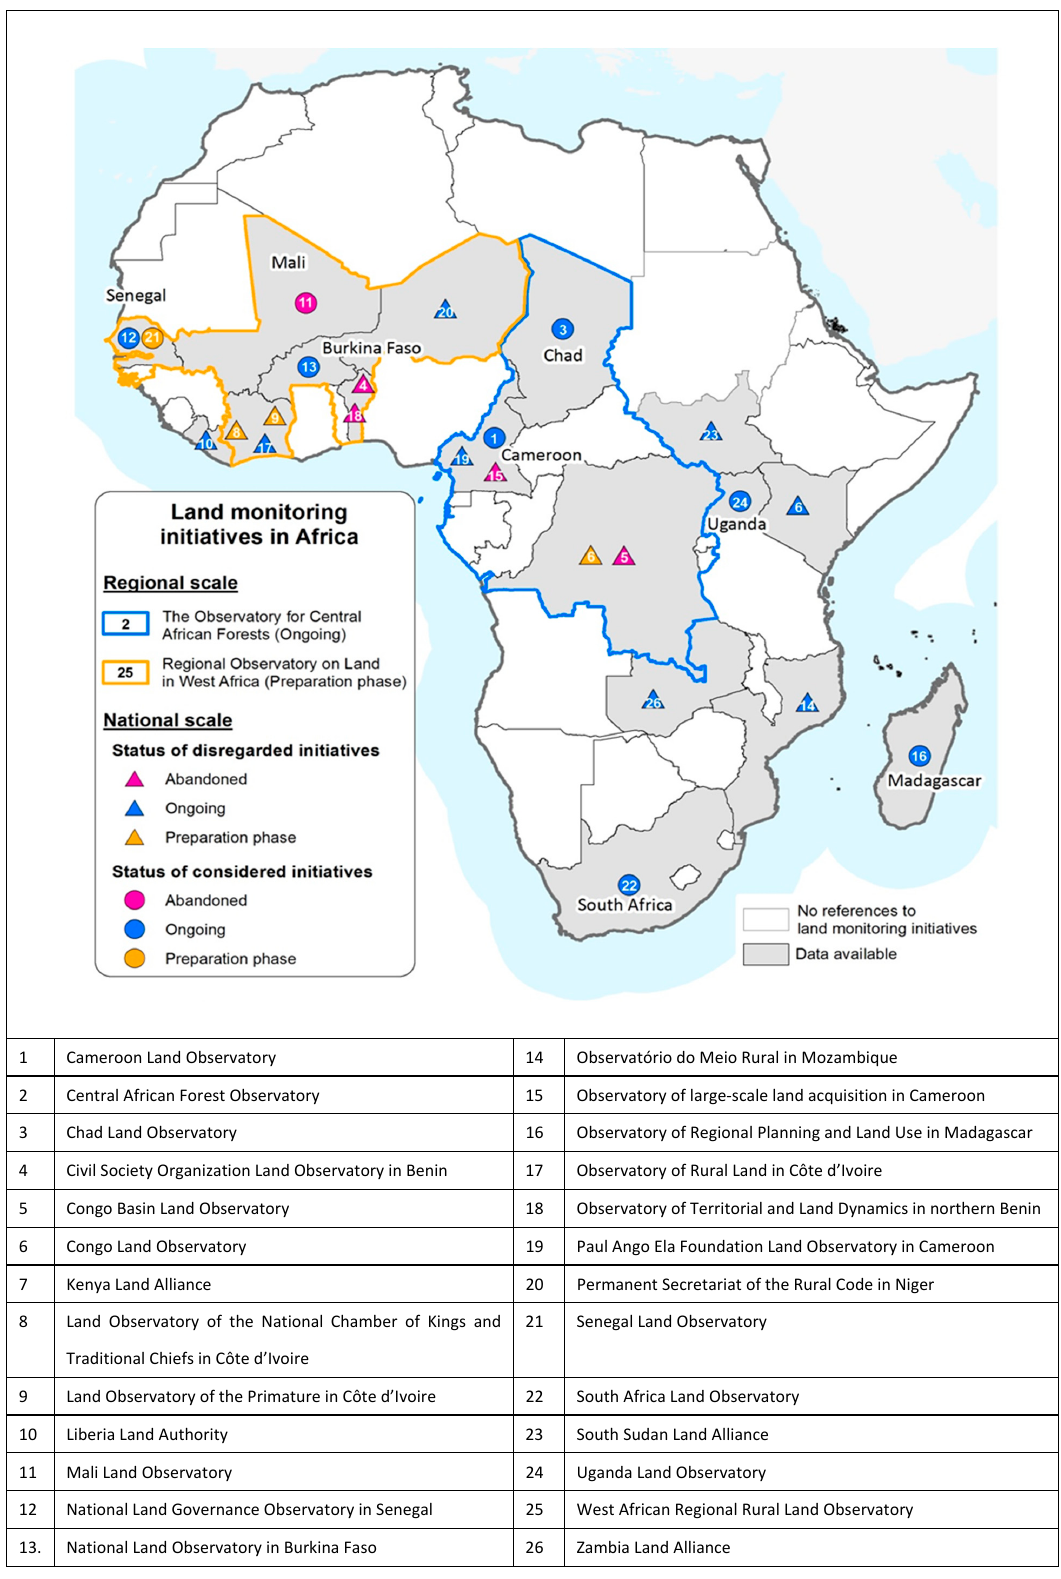
Figure 1. Land monitoring initiatives in